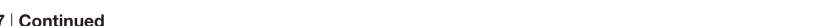
FigUre 7 | continued changes in blood T-cell subsets during simian immunodeficiency virus (siV) infection . (a) Changes in the numbers of naïve T-cells (N—CD95 − CD28 Low ; black), central memory (TCM—CD95 + CD28 Hi ; dark gray), and effector memory (TEM—CD95 + CD28 − ; light gray) T-cell counts; CD4 + (left panel) and CD8 + (right panel) T-cell subsets were evaluated by flow cytometric analysis in macaques ( n = 10) longitudinally sampled over the first 3 weeks of SIV infection. (B) Ki-67 expression in naïve (left panels), TCM (central panels), and TEM (right panels) subsets of CD4 + (top panels) and CD8 + (bottom panels) T-cells, assessed by flow cytometry. (c) The frequency of CCR6 + beta7 + (left panels) and CCR9 + beta7 + (right panels) within CD4 + (top panels) and CD8 + (bottom panels) naïve (black), central memory (dark gray), and effector memory (light gray) T-cells were evaluated by flow cytometric analysis in macaques ( n = 6) sampled longitudinally during the first 3 weeks of SIV infection. Statistically significant differences between pre- and post-infection samples are shown (Wilcoxon signed-rank tests; * p < 0.05, ** p <